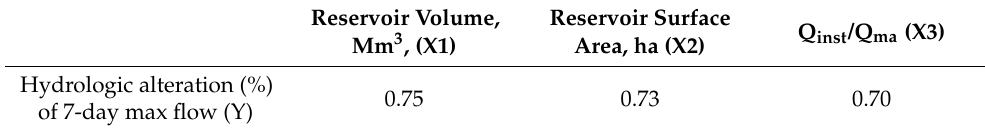
Table 7. Correlation coefficients (only greater than